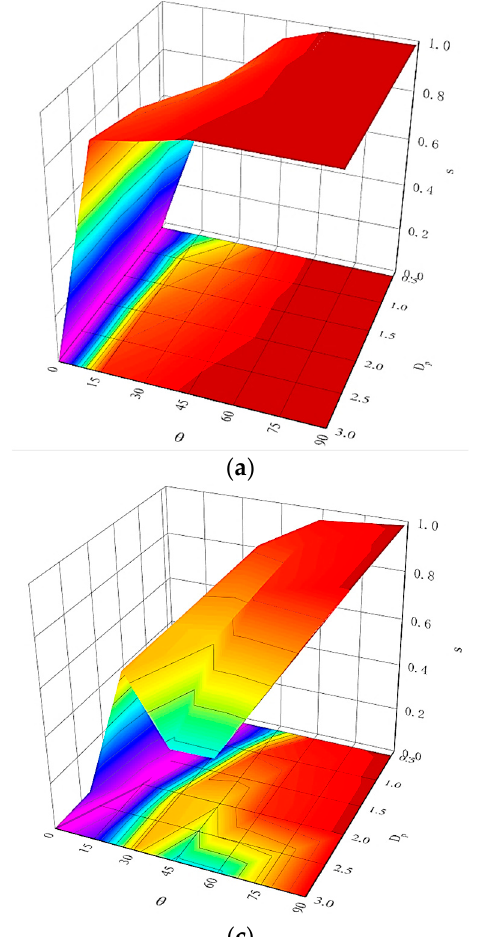
19 of 22 Figure 17. Particles’ trajectories at two different Reynolds numbers. ( a ) Re = 18.18; ( b ) Re = 181.8. Figure 18 shows the dimensionless particle–particle minimum separation at various initial distance and angles and different Reynolds numbers. It is observed that two parti- cles will collide at an initial angle of 0°, but not at an initial angle of 90°, in the focused range of Re. The surface of s gradually transitions from steep in low-angle region to less steep in low-angle region from small Re to large Re, and the range of initial angle and particles’ distance for attraction increases with increasing Re. The domain of attraction (s < 1) is limited to initial angles less than 55° for small Re of 1.82. When Re is 18.18, some limited attraction can be noticed at short distances and high angles. Figure 18a,b shows that at the two lower Reynolds numbers, the minimum distance increases with the in- crease of the initial distance. Figure 18a shows that for pairs with short initial distances, the minimum separation distance varies significantly, with initial angle in the range of 20° and 55°. For pairs with longer initial distances, the minimum separation distance varies greatly with initial angle in the range of 10° to 35°. The domain attraction is independent of initial distances when the initial angle in the range of 0° to 30° and the Re of 18.18 as shown in Figure 18b. When Re is raised to 181.8, it is observed that the domain of attrac-